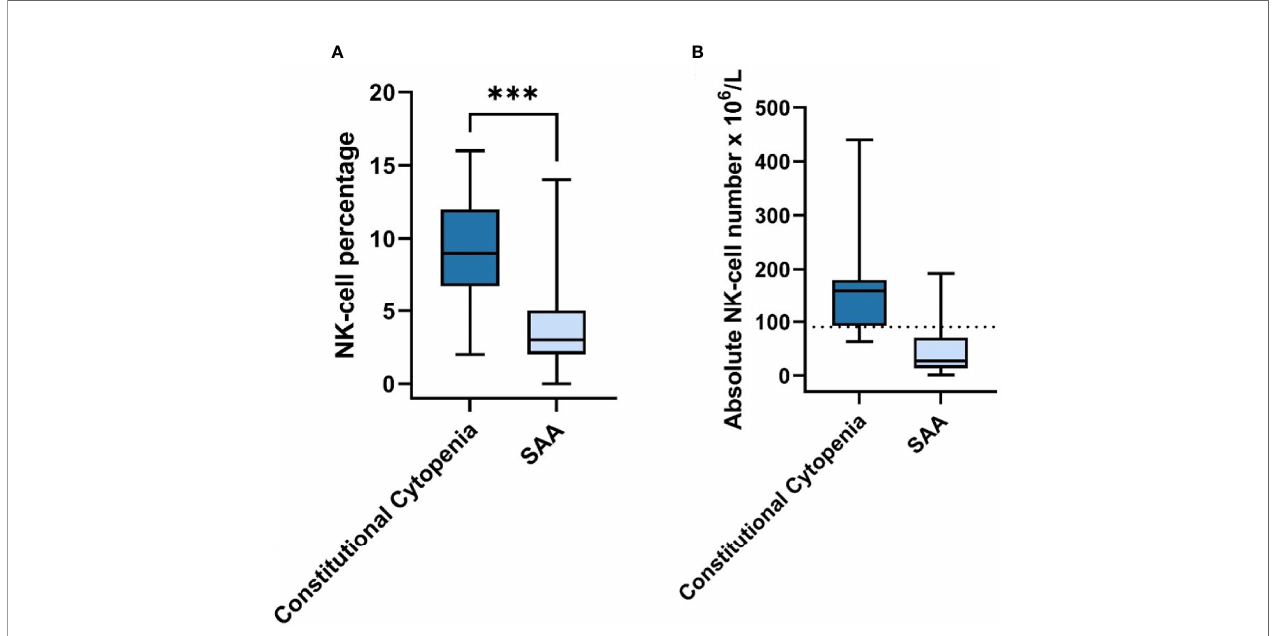
FIGURE 2 | NK-cell Percentage & Absolute Number in Constitutional Cytopenia vs. SAA. (A) NK-cell percentage relative to total lymphocyte count in peripheral blood of patients with identi fi ed causal abnormality (N=14) compared to SAA-patients (N=21) is shown. Data is represented by a boxplot displaying the median, IQR, minimum and maximum. Statistical signi fi cance was determined using the Mann-Whitney U test. ***P < 0.001. (B) Absolute NK-cell number x 10 6 /L in peripheral blood of patients with identi fi ed causal abnormality (N=14) compared to SAA-patients (N=21). Median age for Constitutional Cytopenia vs. SAA groups was 7.0 years (IQR=7,95) vs. 10.3 (IQR=9.0). Data is represented by a boxplot displaying the median, IQR, minimum and maximum, and lower limit of reference range for the age of 5-10 years (dotted